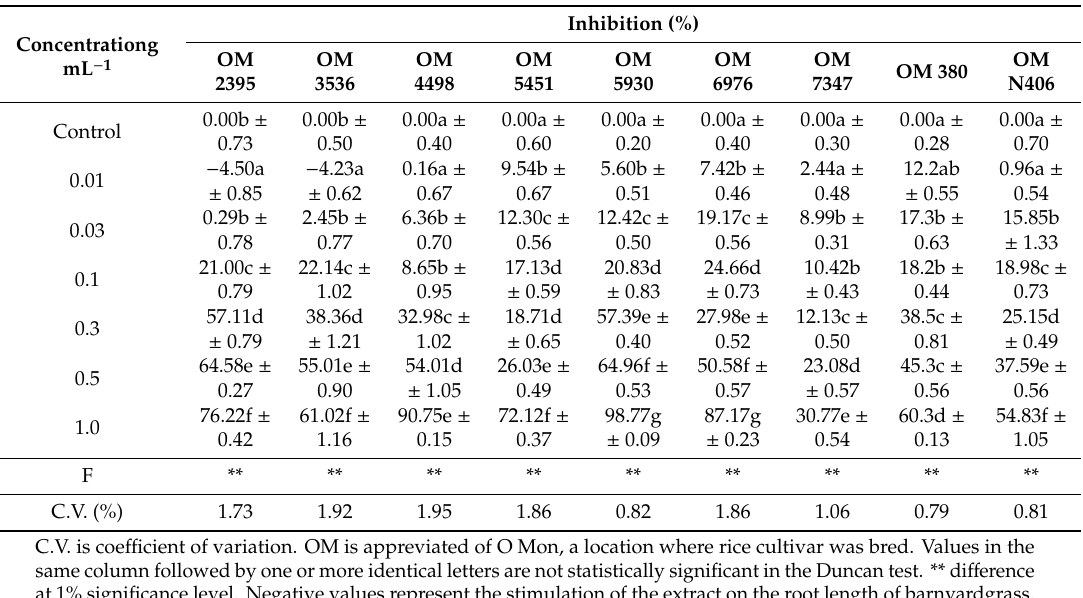
Table 1. E ff ect of MeOH extracts from nine OM rice cultivars on the growth of barnyardgrass shoot.